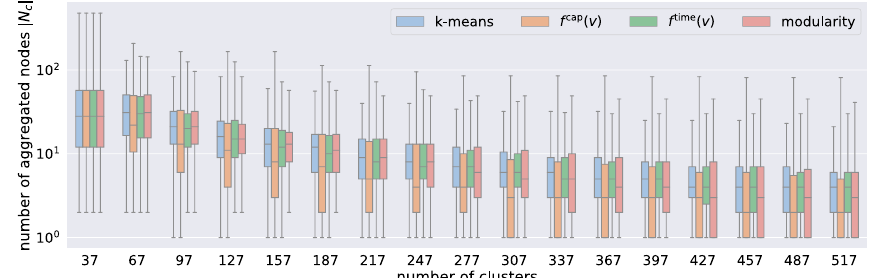
Fig. 5 Clustersizes respective clustering method: The x-axis displays the number of resulting regions, the y-axis the number of aggregated nodes per region, i.e. median, the expansion of the bars the 25% and the 75% quantile. The black vertical lines mark the 1.5-times interquartile